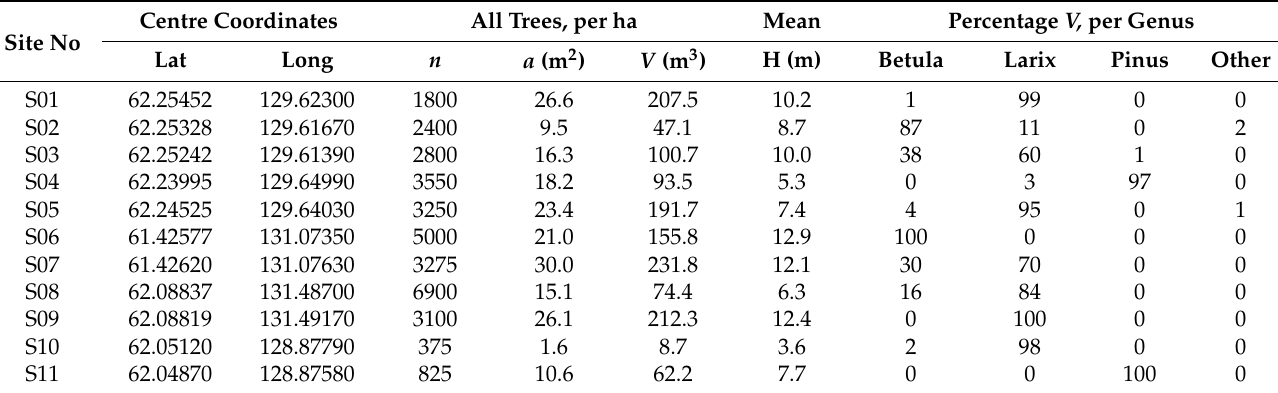
Table 3. Locations and calculated forest parameters of the field plots in the Sakha (S) study area.